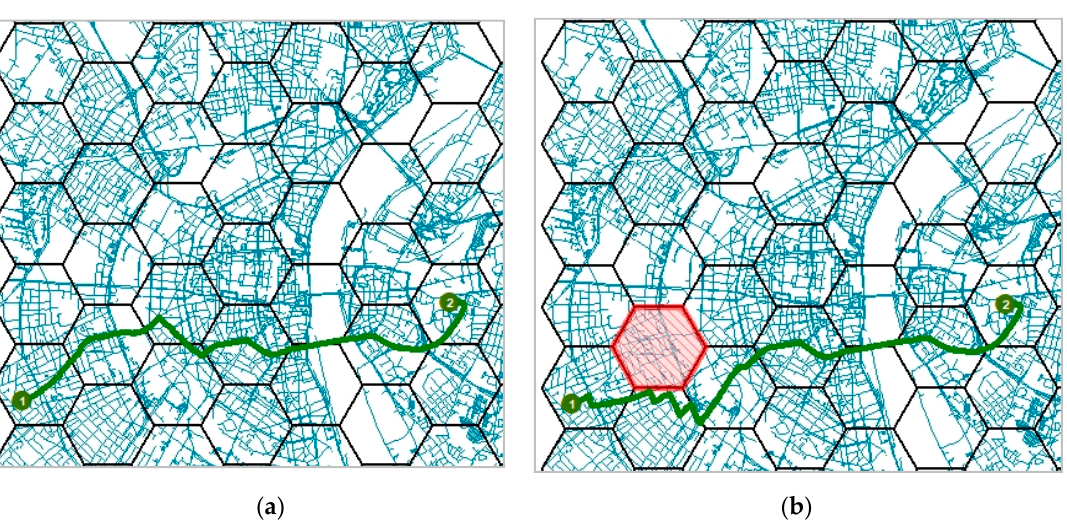
Figure 1. Route without blockage: Response time 8.6 min ( a ) and Route blocked with lower impact: Response time 9.3 min ( b ) (Legend: green = route; grey = road network, red = blocked tile).